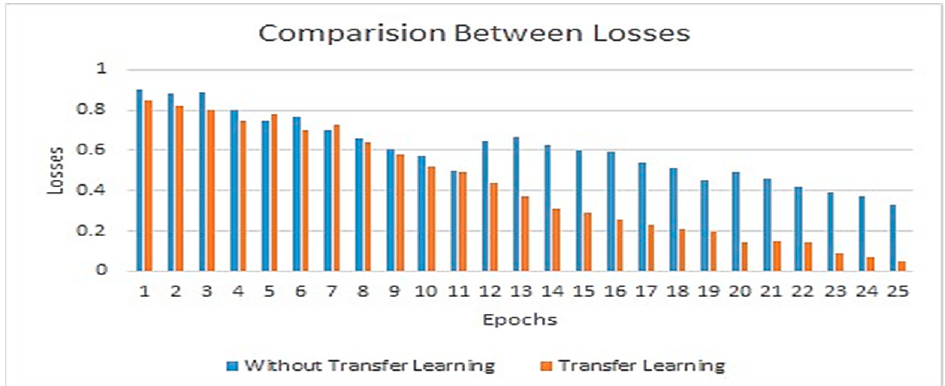
Figure 12. Comparison between losses on CASIA_v2 dataset.